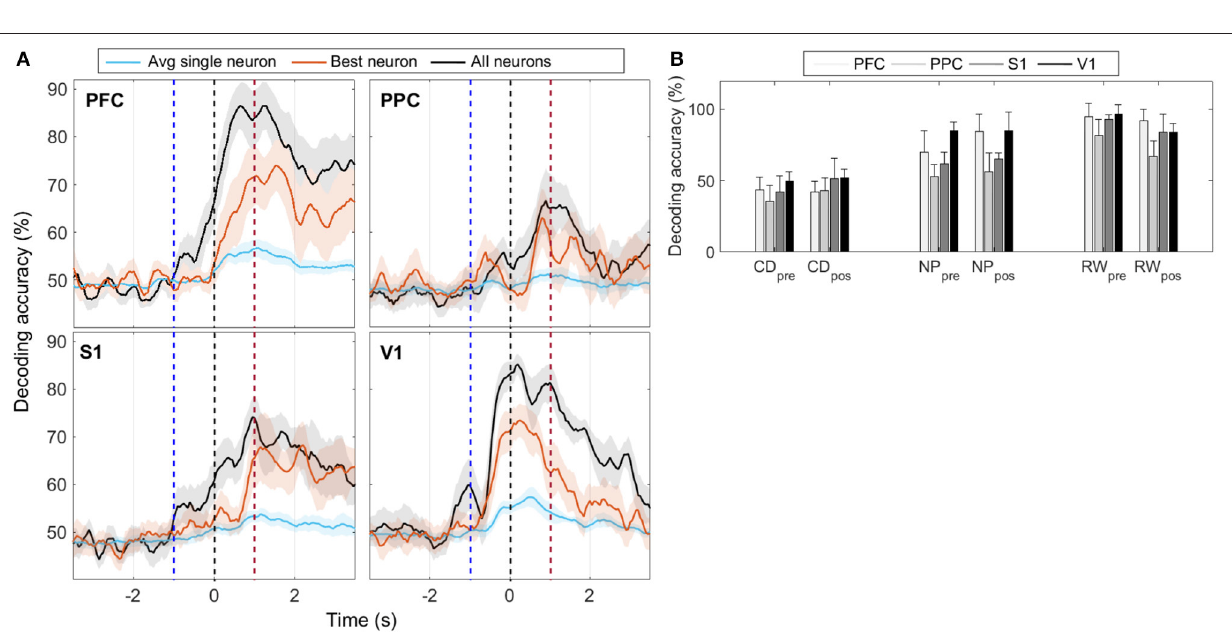
FIGURE 5 | (A) Mean animal response predicted with a SVM decoder. The decoder is fed either with the activity from all recorded cells within each cortical region (black), or with the activity from each neuron, individually. Average (best) single-neuron decoding accuracy is shown in blue (red). For each trial, the decoder mapped seven consecutive 50 ms windows of spike activity (50 ms time step) into left or right reward side. Labeled time points indicate the ending of the sliding time windows. Curves are smoothed using a 5-point moving average filter. Time t 0 s marks the moment rats reach the NP. Shaded regions relate to the standard error of the = mean (calculated across the total number of animals). Dashed blue (red) vertical lines indicate the approximate beginning of trials (reward) time. (B) Mean std of ± animal response predicted with a SVM decoder using the neural activity from a 350 ms window immediately prior to or after the central door (CD), nose-poke (NP), and reward (RW)